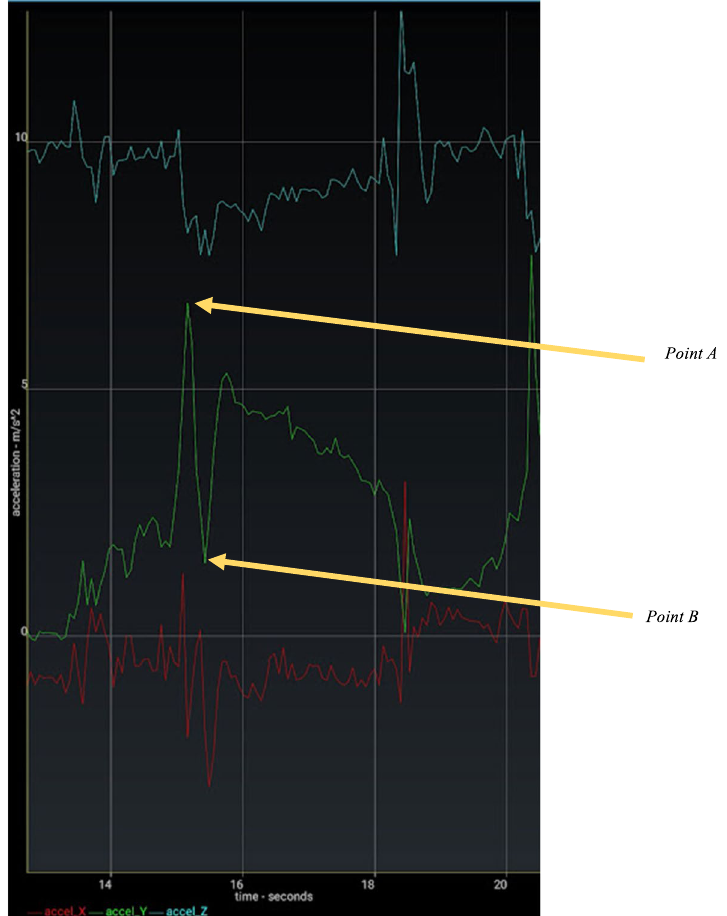
Fig. 3 Evolution of acceleration during the PS test on a pathological knee with an anterior cruciate rupture. The Y axis (green) showed the flexion‑extension movement induced by the maneuver. The subluxation and abrupt reduction of the anterior compartment of the tibia was highlighted by the abrupt deceleration with point A corresponding to the maximum of the subluxation and point B the reduction. The difference between point A and point B was called the alpha